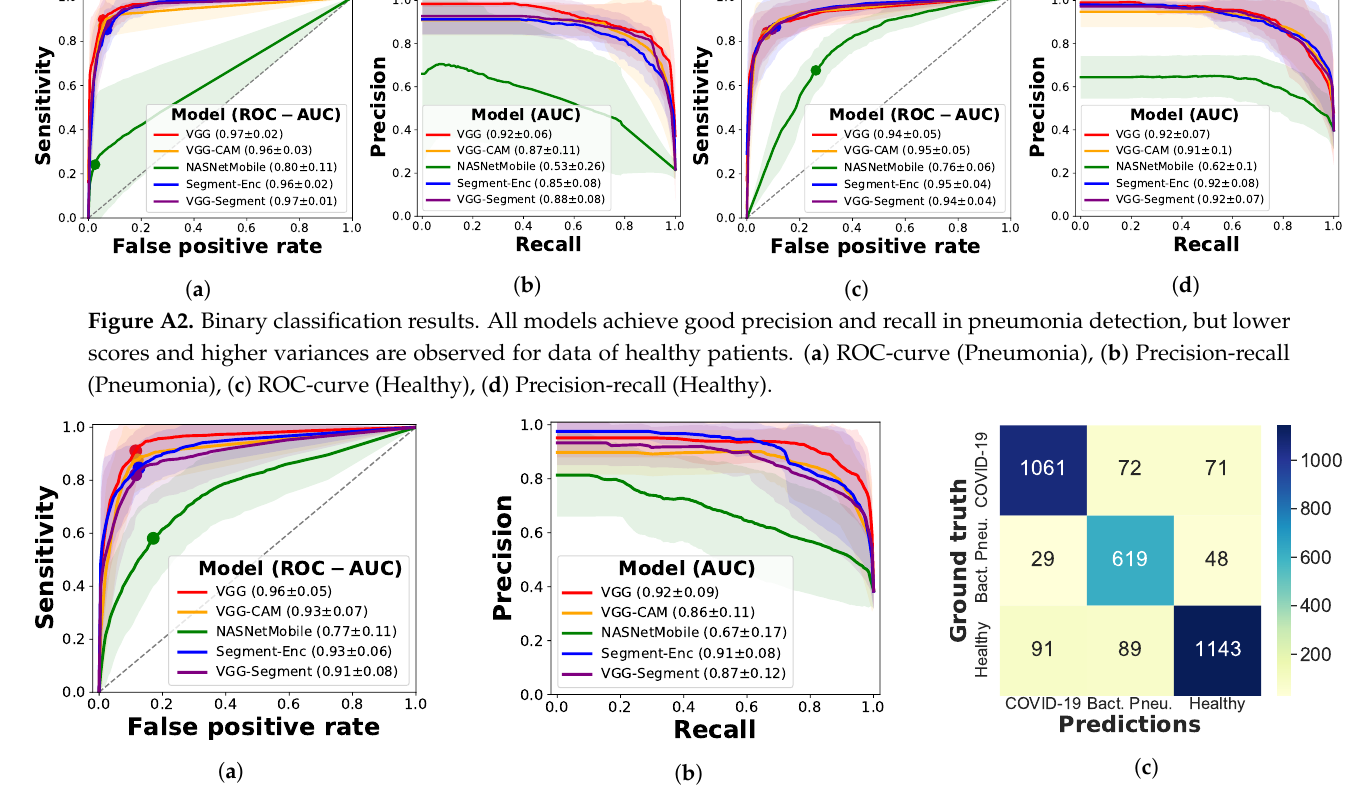
Figure A3. COVID-19 detection and absolute confusion matrix. ( a ) ROC-curve (COVID-19), ( b ) Precision-recall-curve (COVID-19), ( c ) Absolute confusion matrix ( VGG-CAM